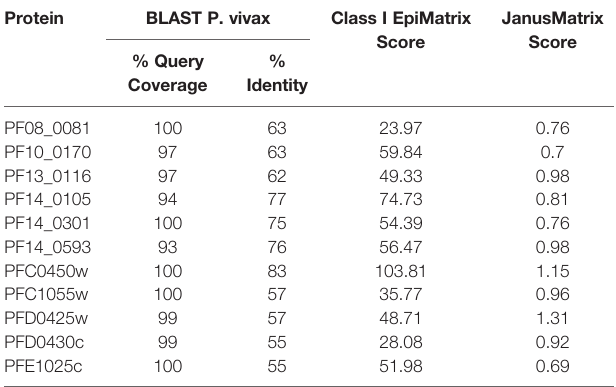
TABLE 1 | Identity and immunogenicity scores for eleven selected